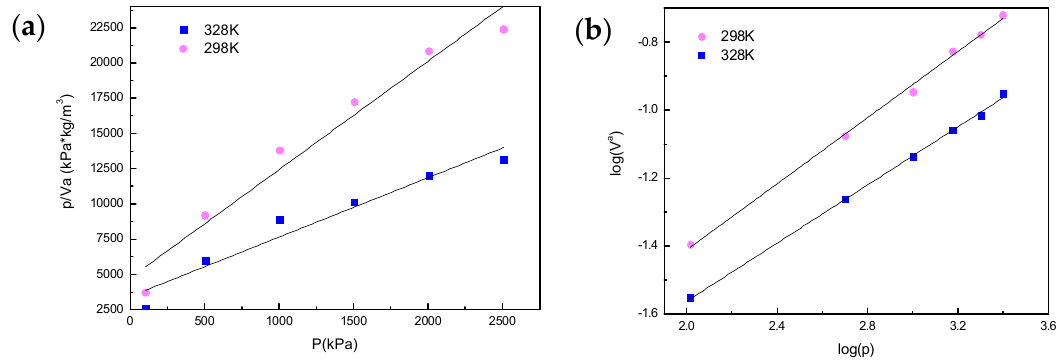
Figure 13. ( a ) Hydrogen adsorption capacity of graphene with the Langmuir model and ( b ) Freundlich model.